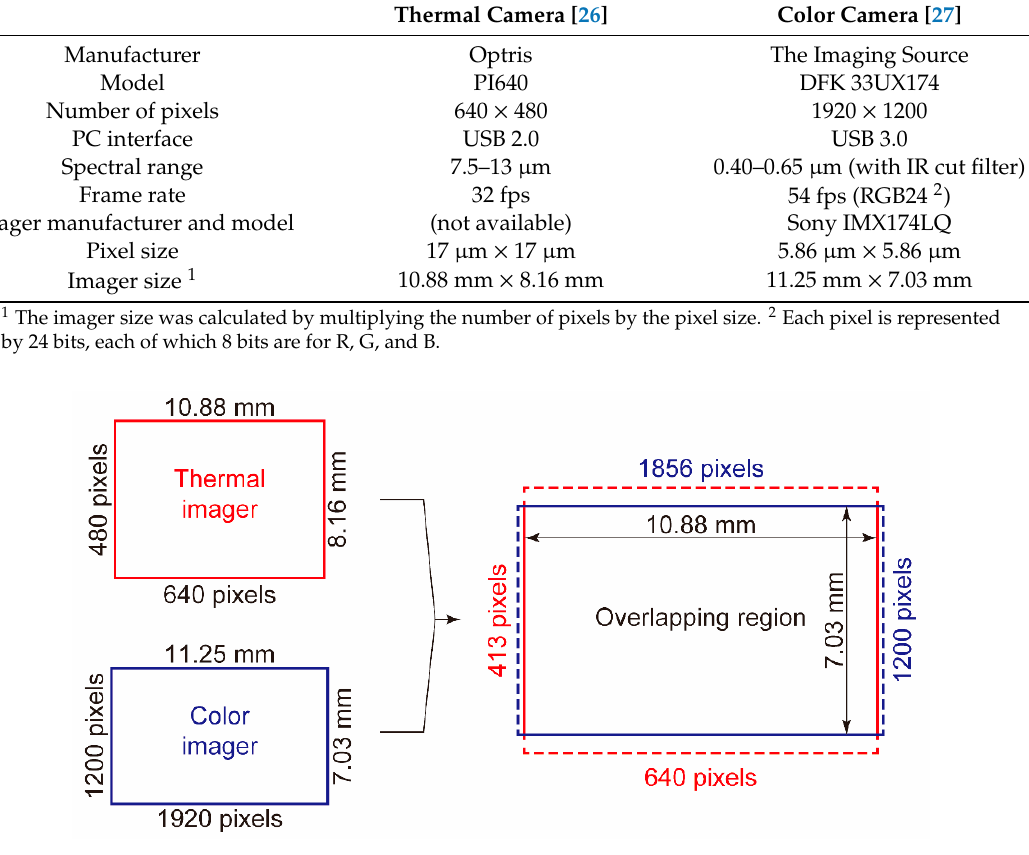
Figure 2. Overlapping region of thermal and visible imagers.